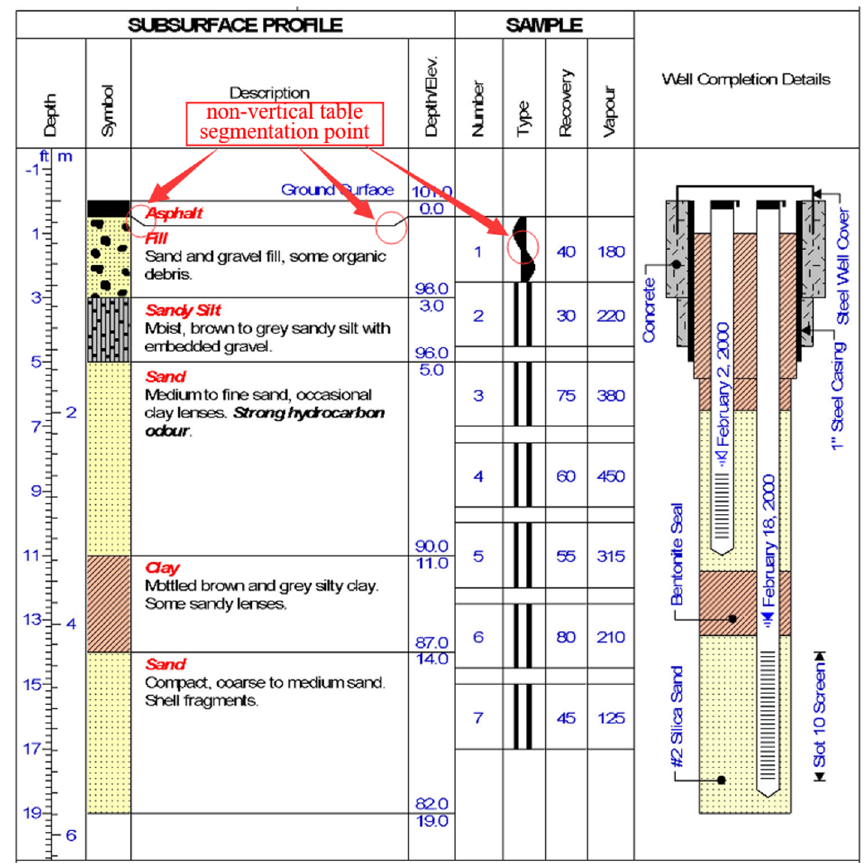
Figure 1. Example of old a papery borehole log with some non-vertical table segmentation points.